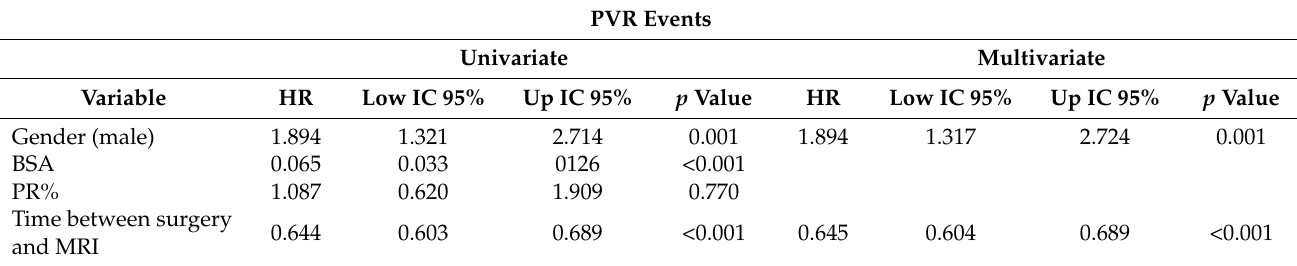
Table 7. Predictors for PVR. Legend: BSA = body surface area; PR = pulmonary regurgitation